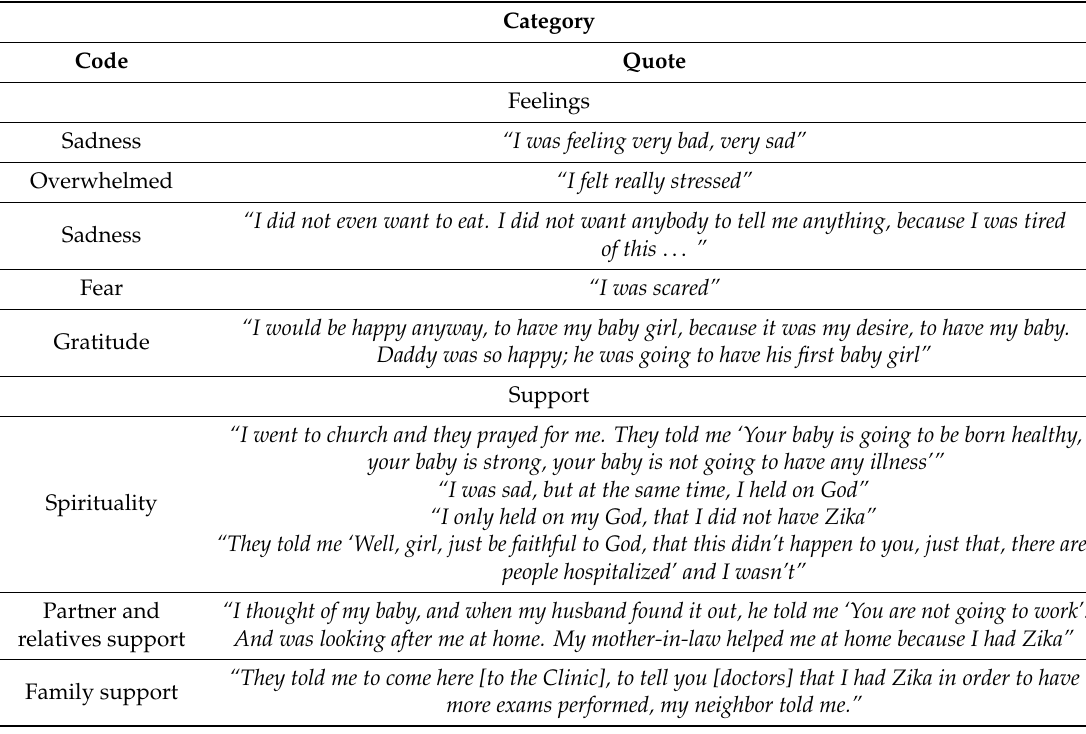
Table 4. The emotional state of mothers carrying normocephalic